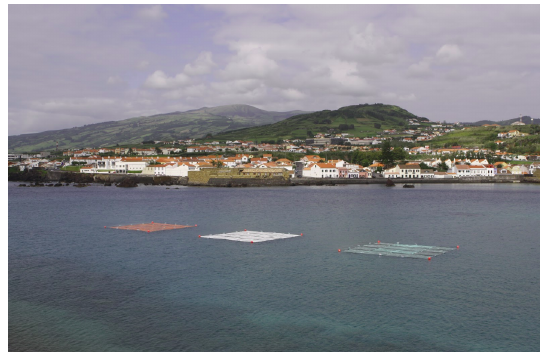
Figure 8. Picture of the three targets used. From left to the right: low density polyethylene orange target (with used oyster spat collectors), white plastic film target and rope target. The flights were divided into two modules: manned fixed wing and unmanned flights.